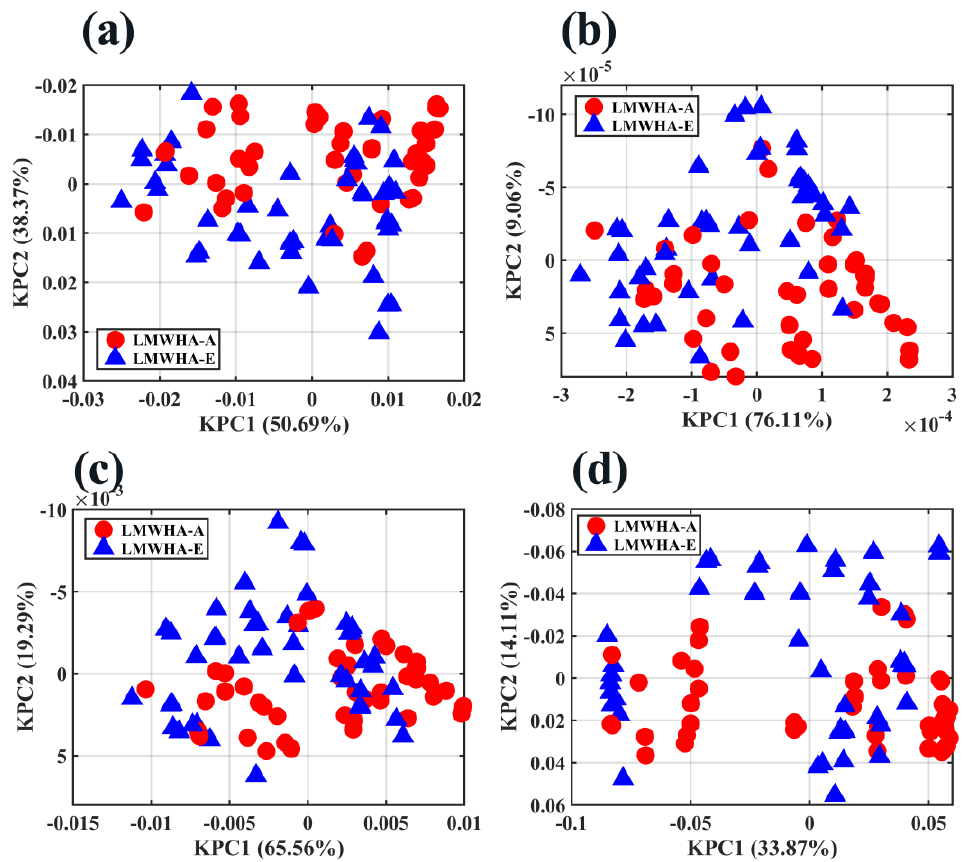
Figure 6. 2D score plots of KPCA with ( a ) Gaussian kernel, ( b ) polynomial kernel, ( c ) sigmoid kernel, and ( d ) Laplacian kernel.